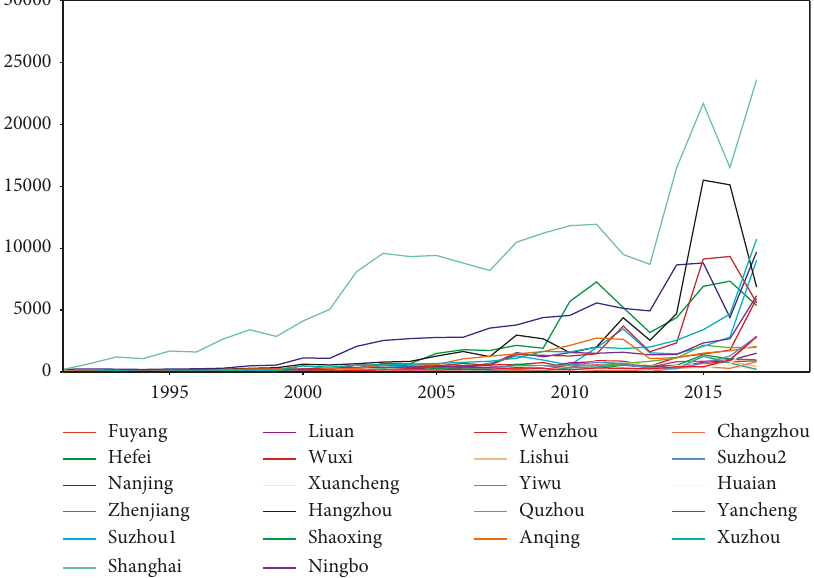
Figure 10: Chart of the growth of companies in the Yangtze River Delta from 1990 to